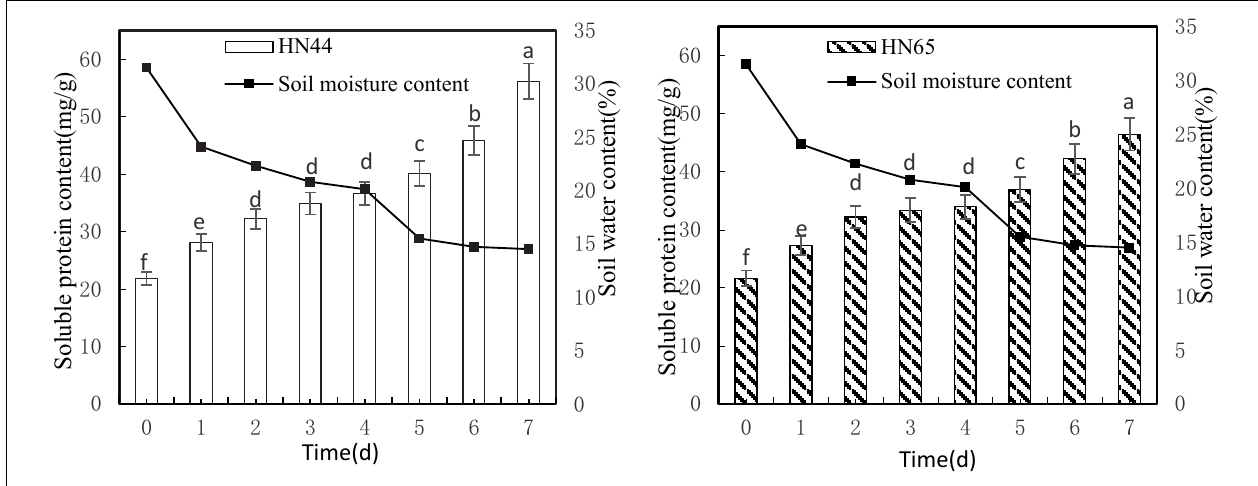
FIGURE 4 | Effect on soluble protein content under different soil water contents. Indicates that the values marked with different letters are significantly different, and those marked with the same letter are considered to be statistically insignificant. TABLE 5 | Effect of drought on the relative growth rate of soluble protein content (%). Varieties 0